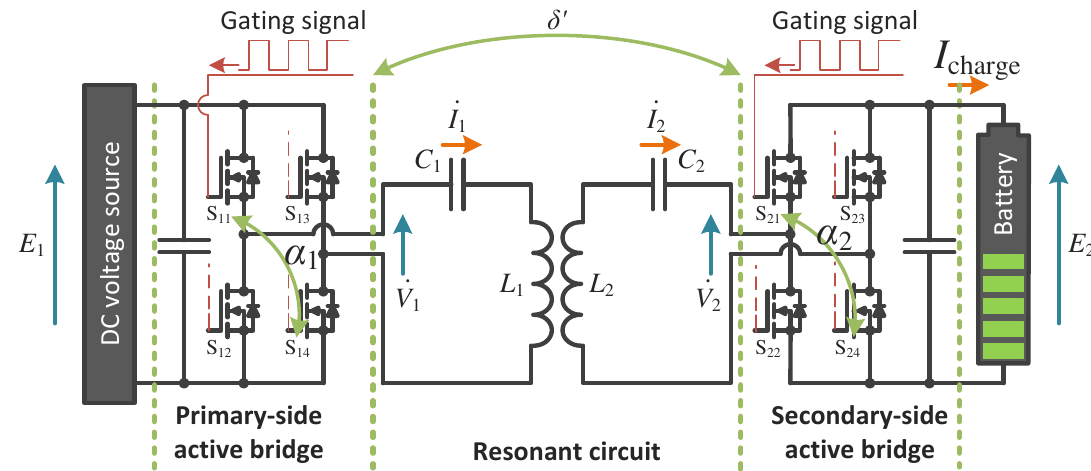
Figure 1. The bi-directional inductive power transfer (IPT) system studied in this